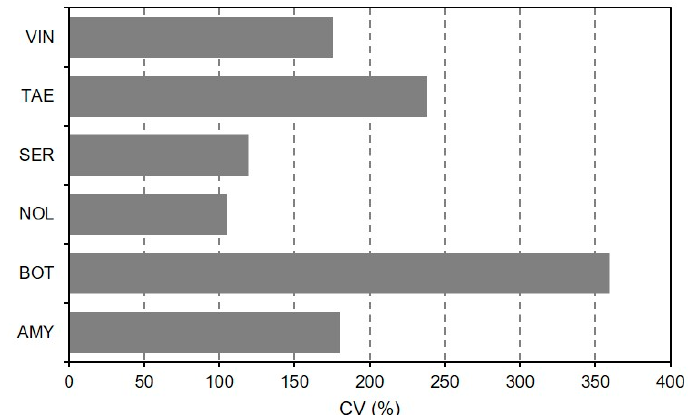
Figure 2. Coefficient of variation (CV, %) for the numbers of colony forming units (CFUs) of the six BCAs that developed on bunch trash. After it was treated with one of six BCAs, the bunch trash was subjected to different temperature and relative humidity regimes for different BCA colonization periods. Full BCA names and background information are provided in Table 1.